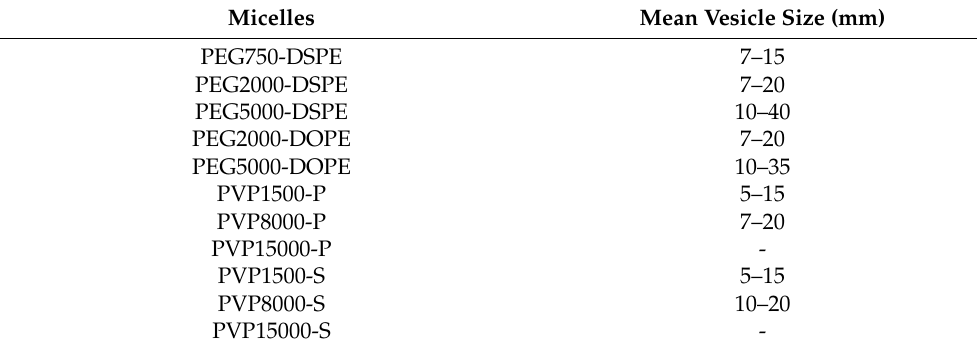
Table 3. Phospholipids used in the formation of micelles and the final particle